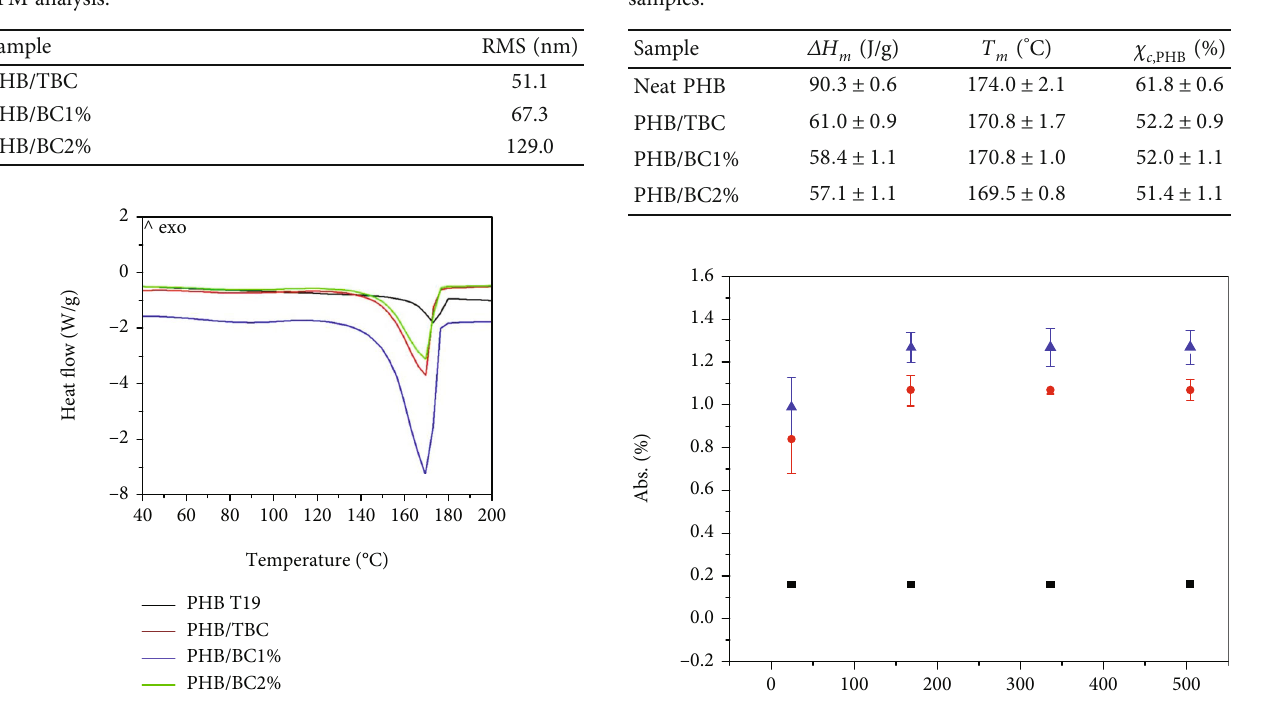
Table 3: Thermal properties of PHB, PHB/TBC, and PHB/BC samples.